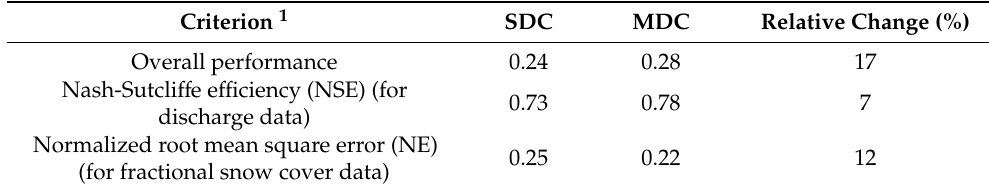
Table 3. Performance of single-dataset and multi-dataset calibration (SDC and MDC) in the validation period, based on di ff erent criteria.